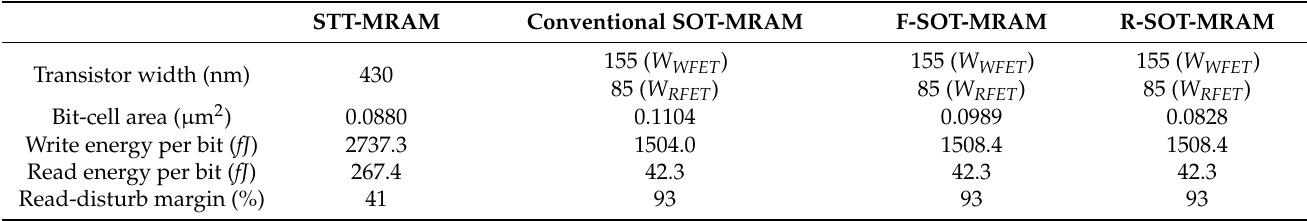
Table 2. Comparison of different